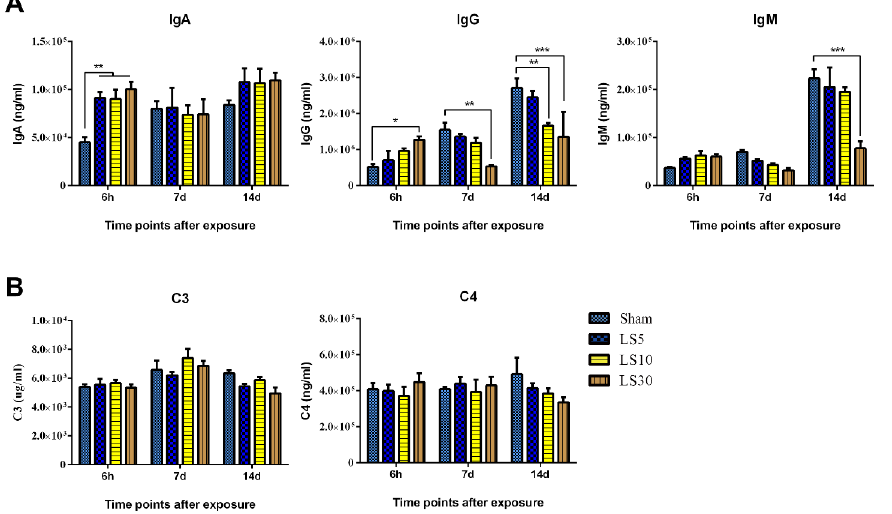
Figure 4. Multifrequency microwaves decreased the levels of IgG and IgM but did not complement proteins in peripheral blood. Wistar rats were exposed to multifrequency microwaves at average power densities of 5, 10, and 30 mW/cm 2 . At 6 h, 7 d, and 14 d after exposure, peripheral blood was collected, and serum was separated by centrifugation. The levels of immunoglobulins (IgA, IgM, and IgG) ( A ) and complement proteins (C3 and C4) ( B ) were analyzed by enzyme-linked immunosorbent assay (ELISA). Data are shown as the mean±s.e.m., * p < 0.05, ** p < 0.01, *** p < 0.001, vs. corresponding groups.